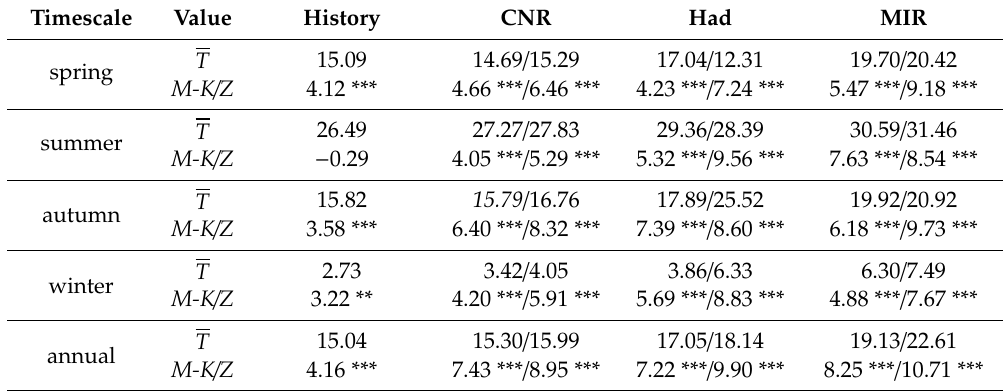
Table 4. The mean value of annual and seasonal average temperature ( T / ◦ C) and Mann-Kendall test values ( Z ) historically (1960–2015) and in the future